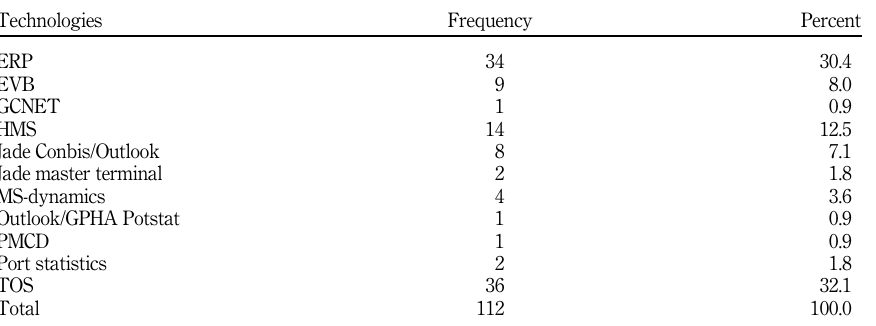
Table 1. Technologies used at